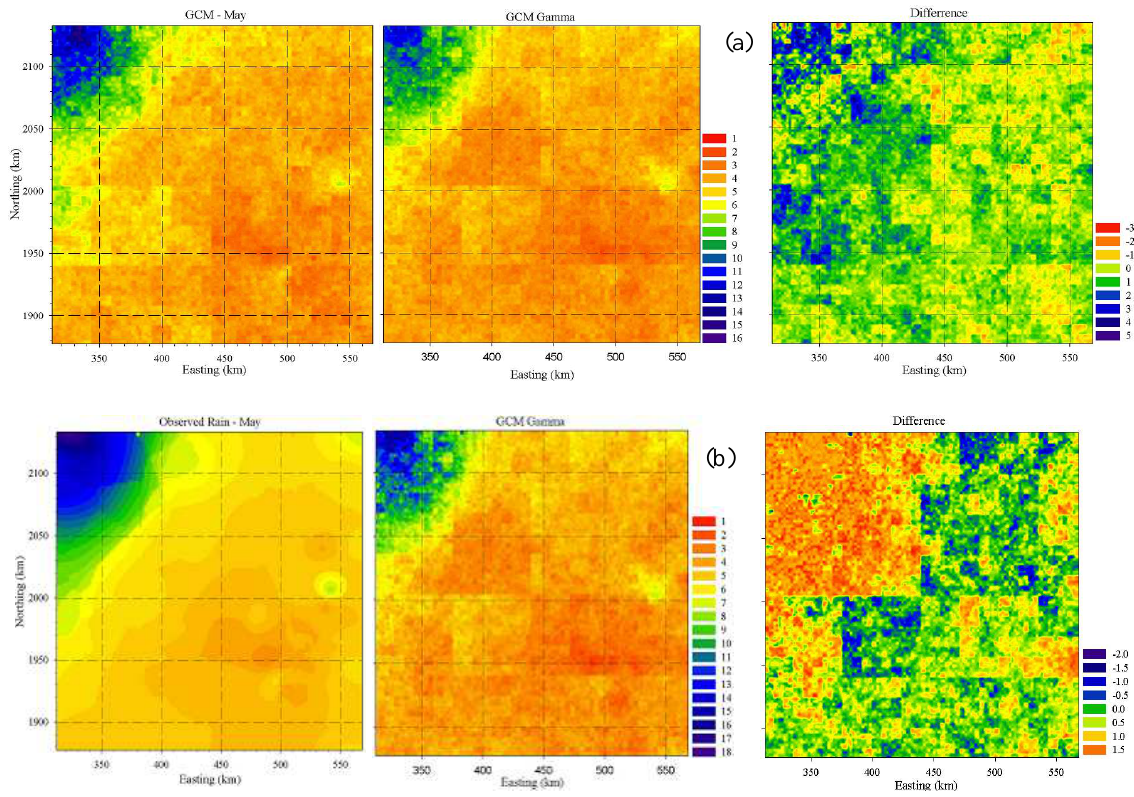
Fig. 13. Spatial distribution pattern shows (a) average downscaled maps of raw GCM and bias-corrected downscaled GCM (b) average observed rain field and bias-corrected downscaled